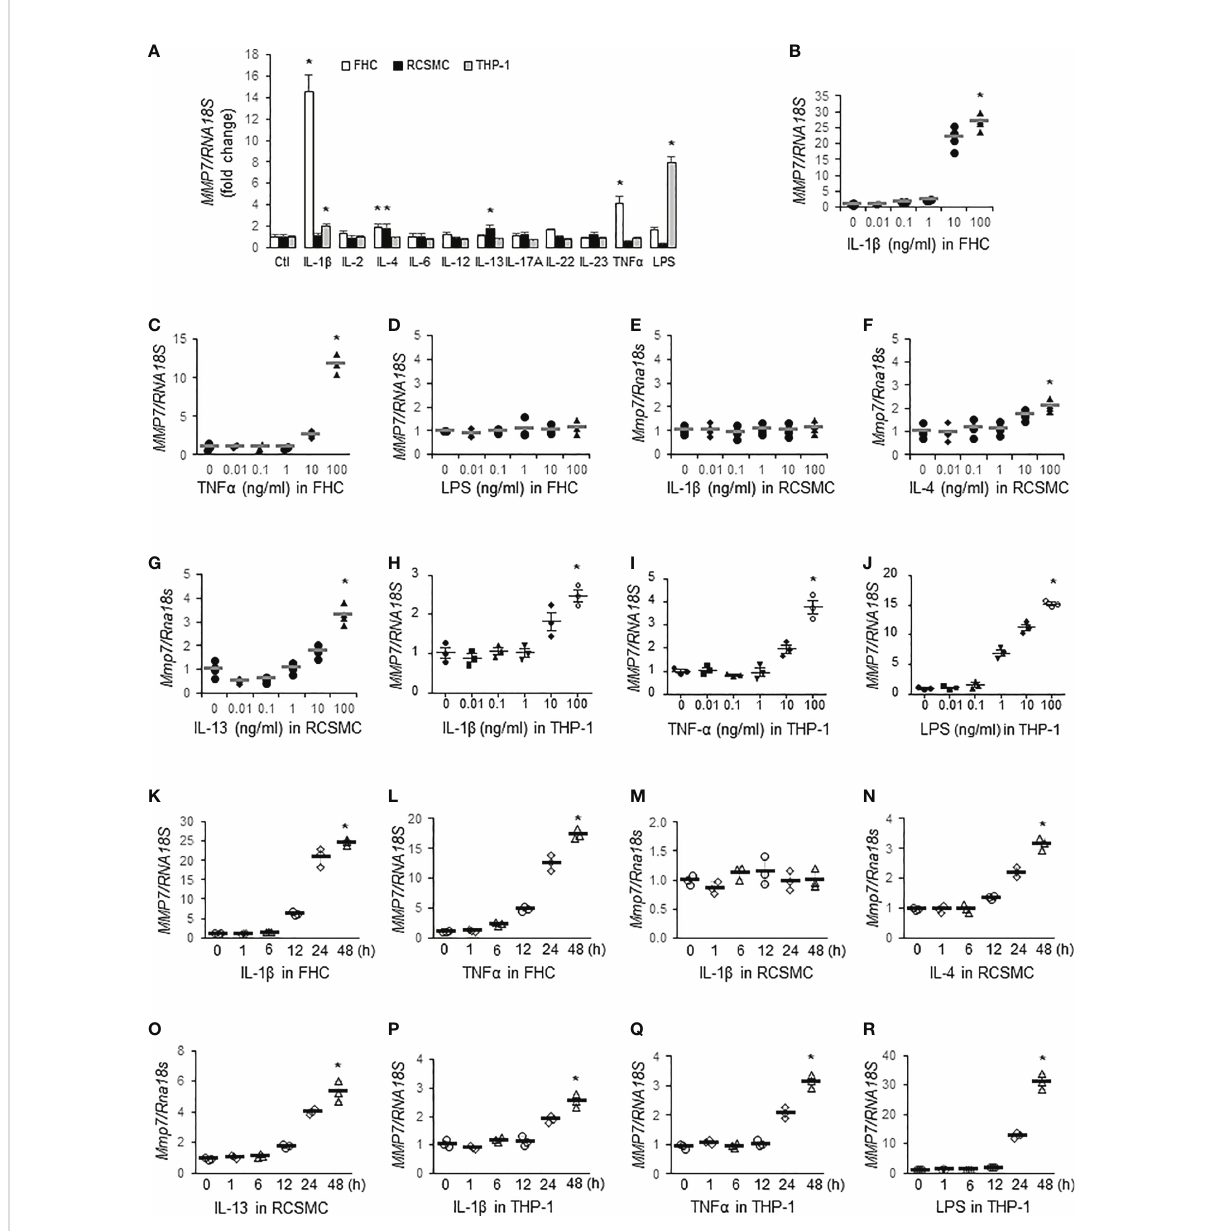
FIGURE 2 MMP-7 is up-regulated by in fl ammatory mediators in epithelial cells, smooth muscle cells, and macrophages of the colon. (A) RT-qPCR analysis of MMP7 mRNA levels in human FHC (white bars), rat colonic smooth muscle (RCSMC, black bars), and human THP-1 (gray bars) cells treated with 10 ng/mL indicated cytokine or LPS. RT-qPCR assays also determined the MMP7 mRNA levels in the FHC cells treated with serial doses of IL-1 b (B) , TNF a (C) , or LPS (D) , in RCSMC treated with IL-1 b (E) , IL-4 (F) , or IL-13 (G) , and in THP-1-derived macrophages treated with IL-1 b (H) , TNF a (I) , or LPS (J) for 24 hours. Time course experiments were performed to evaluate temporal changes of MMP7 mRNA expression in FHC cells treated with 10 ng/ml IL-1 b (K) or 100 ng/ml TNF a (L) , in RCSMC treated with 10 ng/ml IL-1 b (M) , 100 ng/ml IL-4 (N) , or 100 ng/ml IL-13 (O) , and in THP-1 cells treated with 10 ng/ml IL-1 b (P) , 10 ng/ml TNF a (Q) , or 100 ng/ml LPS (R) . n=3 or 4. * p